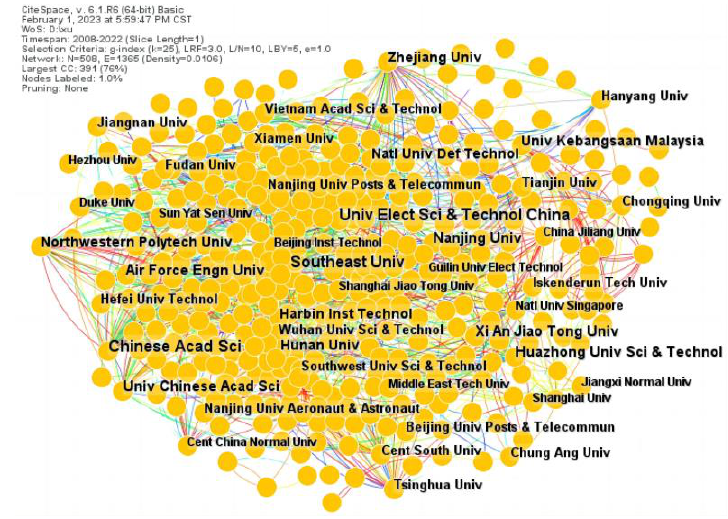
Figure 3. Institutional collaboration network map. Table 2. Top ten most productive institutions in the research of metamaterial absorber.